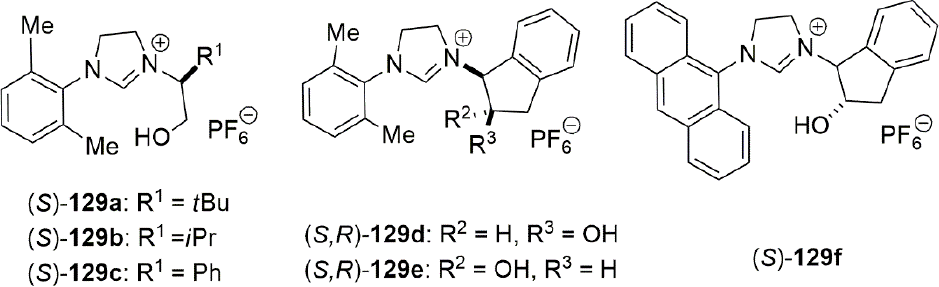
Figure 11. Chiral mono ‐ and bidentate NHC ligands [156]. Scheme 29. Copper catalyzed 1,4 addition of organoboronates to alkenes [156]. For the catalytic asymmetric coupling reaction shown in Scheme 29, a series of bidentate NHC ligands in the presence of copper chloride or copper bromide were tested, with the best result in terms of enantioselectivity observed when ( S ) ‐ 129f with a bulky 9 ‐ anthryl was used. The combination of this ligand with CuBr to the formation of 132 with 92% ee and 86% yield. Various aryl groups from boronates and alkyls such as 1 ‐ cyclohexenyl ‐ and methylboronates can also be incorporated effectively from the nucleophilic component into benzylidene cyanoacetate [155]. Using the same class of NHC ‐ Cu systems, Hayashi et al. also reported the asymmetric allylic substitution of allyl phosphates with aryl ‐ and alkenylboronates [156].